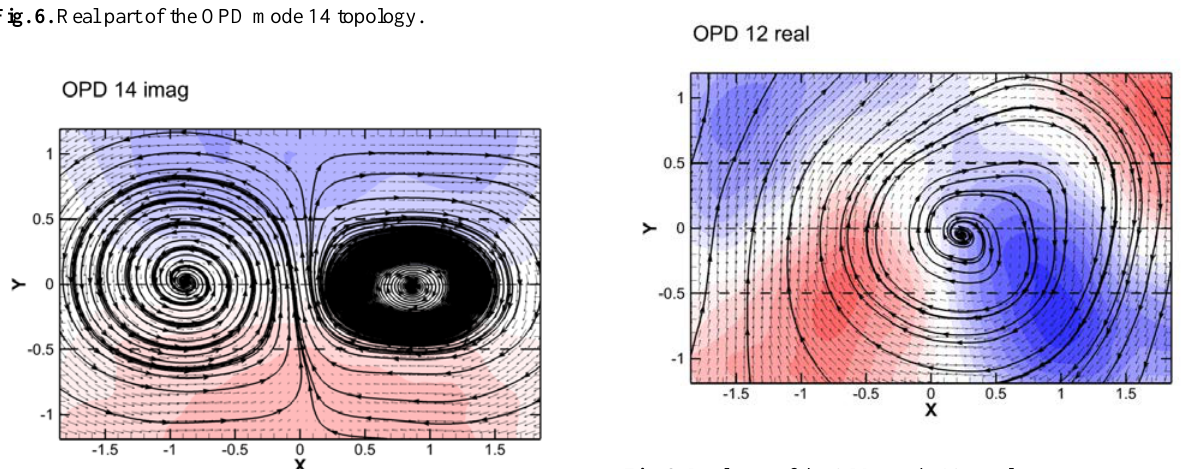
Fig. 8. Real part of the OPD mode 12 topology .